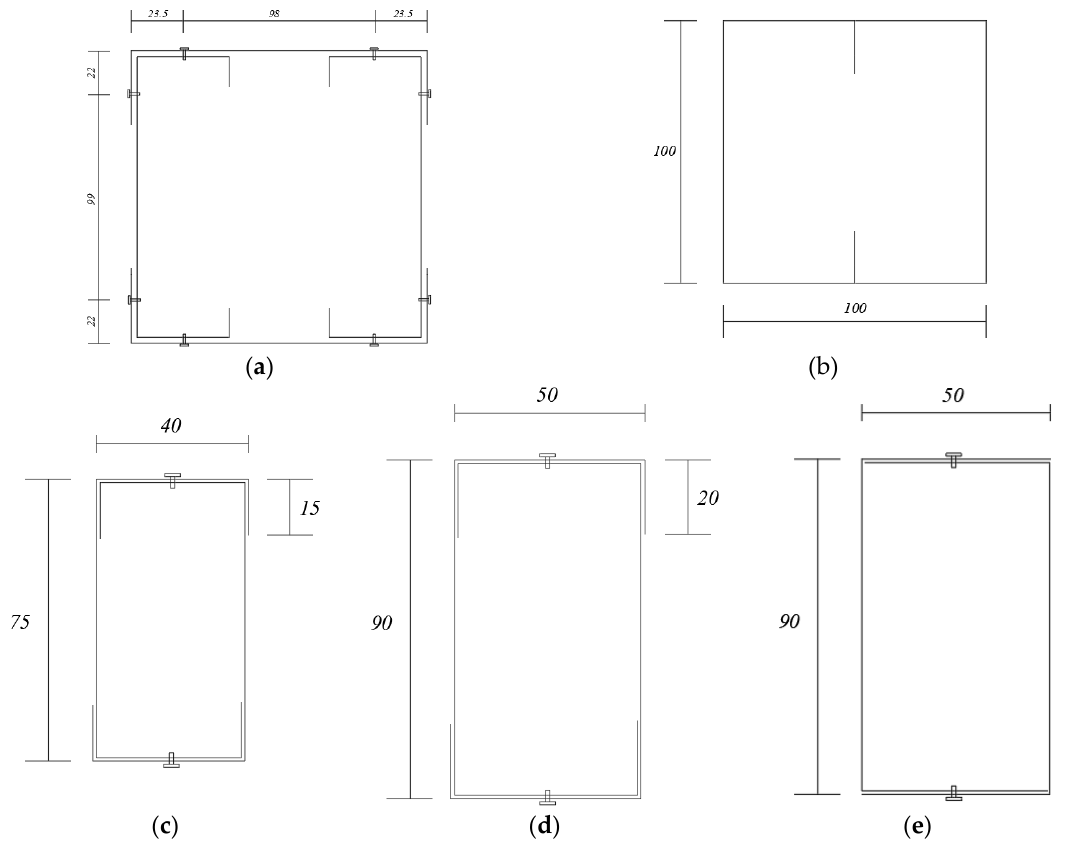
Figure 1. CFS-FTF built-up cross-section shapes: ( a ) FTF gapped built-up section [13,14]; ( b ) FTF lip connected built-up section [15]; ( c ) FTF flange connected built-up section [2]; ( d ) FTF built-up lipped channel section; and ( e ) FTF built-up unlipped channel section.